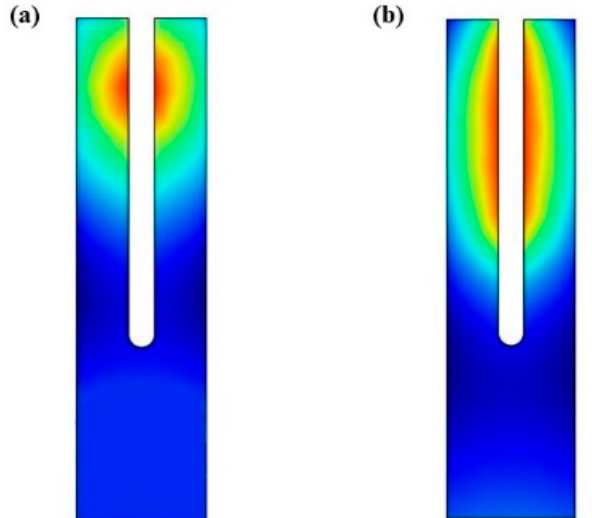
Figure 3. ( a ) Pressure distribution generated by a circular spot and ( b ) pressure distribution generated by elliptical spot.